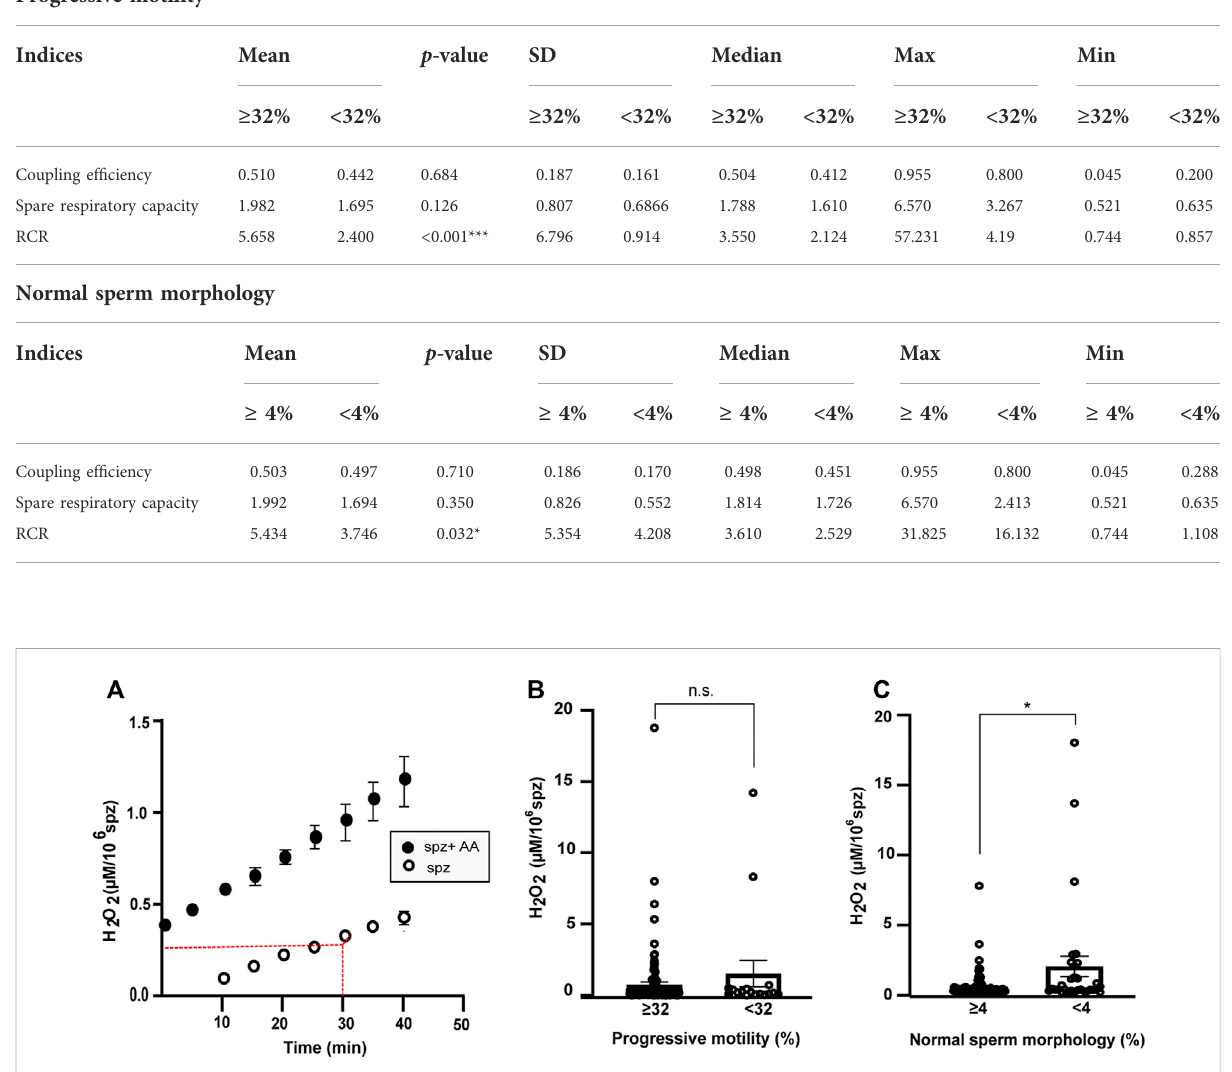
TABLE 3 Main respiratory indices classi fi ed by sperm parameters. RCR = respiratory control ratio SD = standard deviation. Max = maximum. Min = minimum. Statistic analysis, Man Whitney test. * p < 0.05, *** p < 0.001. Progressive motility